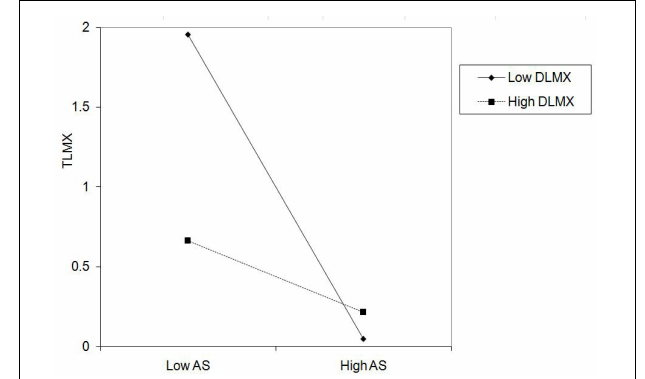
FIGURE 3 | Interaction of abusive supervision and DLMX on TLMX.